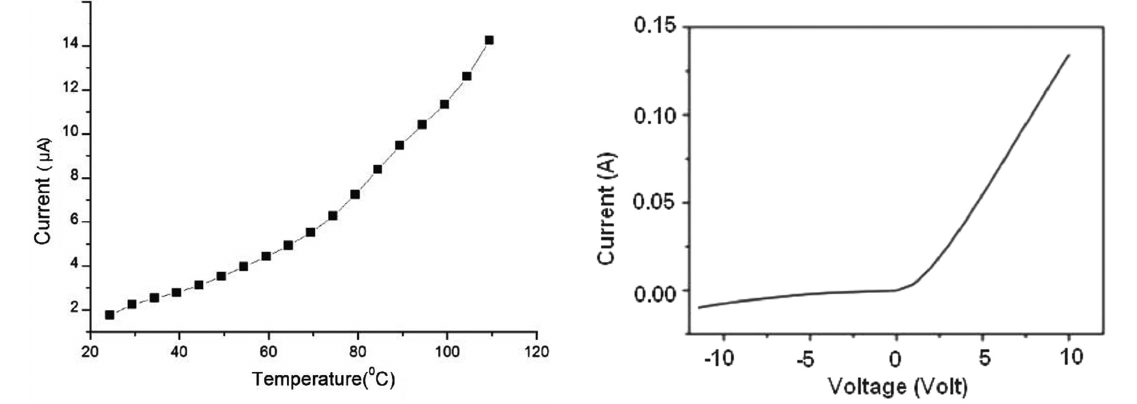
Figure 11. I‑V characteristics of CuSe films.